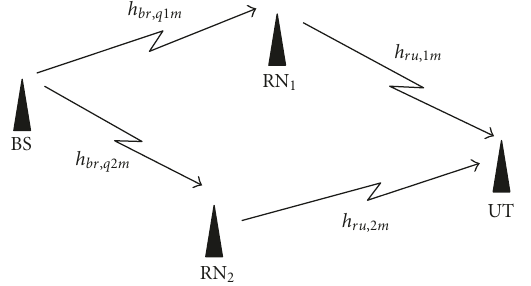
Figure 1: System model for the RA scheme with 2 RNs and M antennas at each relay (RA K × M × 1).